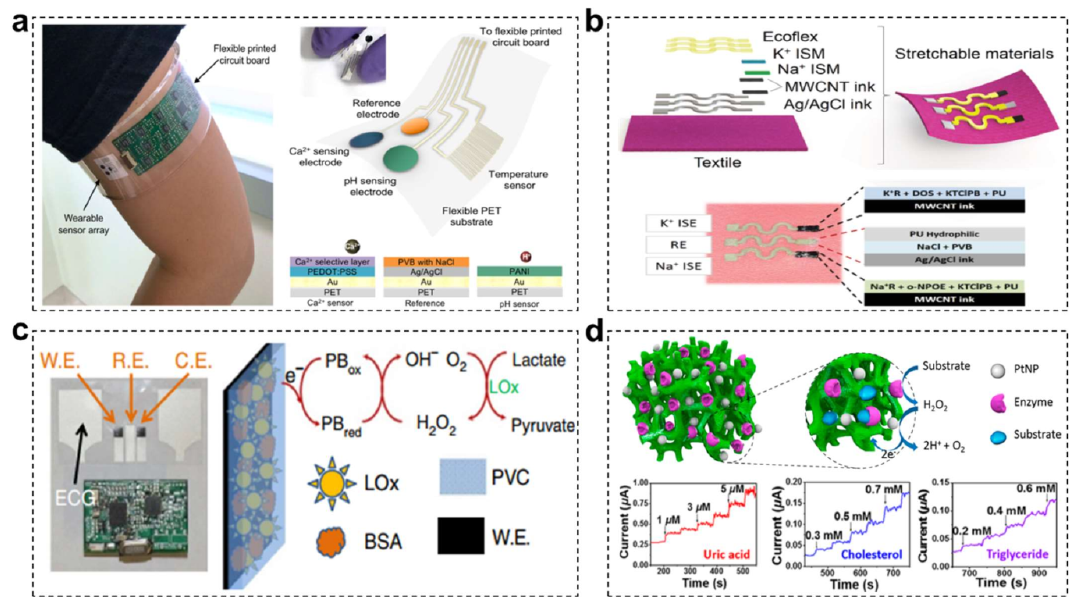
Figure 3. ( a ) The fully integrated wearable multiplexed sensing system on a subject’s arm. Di- agrams of a flexible sensor array containing Ca 2+ , pH, and temperature sensors patterned on a flexible polyethylene terephthalate substrate and corresponding surface membrane electrode com- positions. Reprinted with permission from ref. [113]. Copyright 2016 American Chemical Society. ( b ) Schematic representation of the tailor-made stretchable materials and the wearable sensor based on textile and ion-selective membranes composition. Reproduced with permission [114]. Copyright 2016, Wiley-VCH. ( c ) The images of a Chem-Phys patch along with the wireless electronics. The schematics show the lactate oxidase-based lactate biosensor along with the enzymatic and detection reactions. Reproduced with permission [116]. Copyright 2016, Springer Nature. ( d ) Schematic illustration of the general sensing mechanism of the resultant hydrogel electrode platform based on PANI/PtNPs/enzyme hybrid films. Reprinted with permission from ref. [117]. Copyright 2015 American Chemical